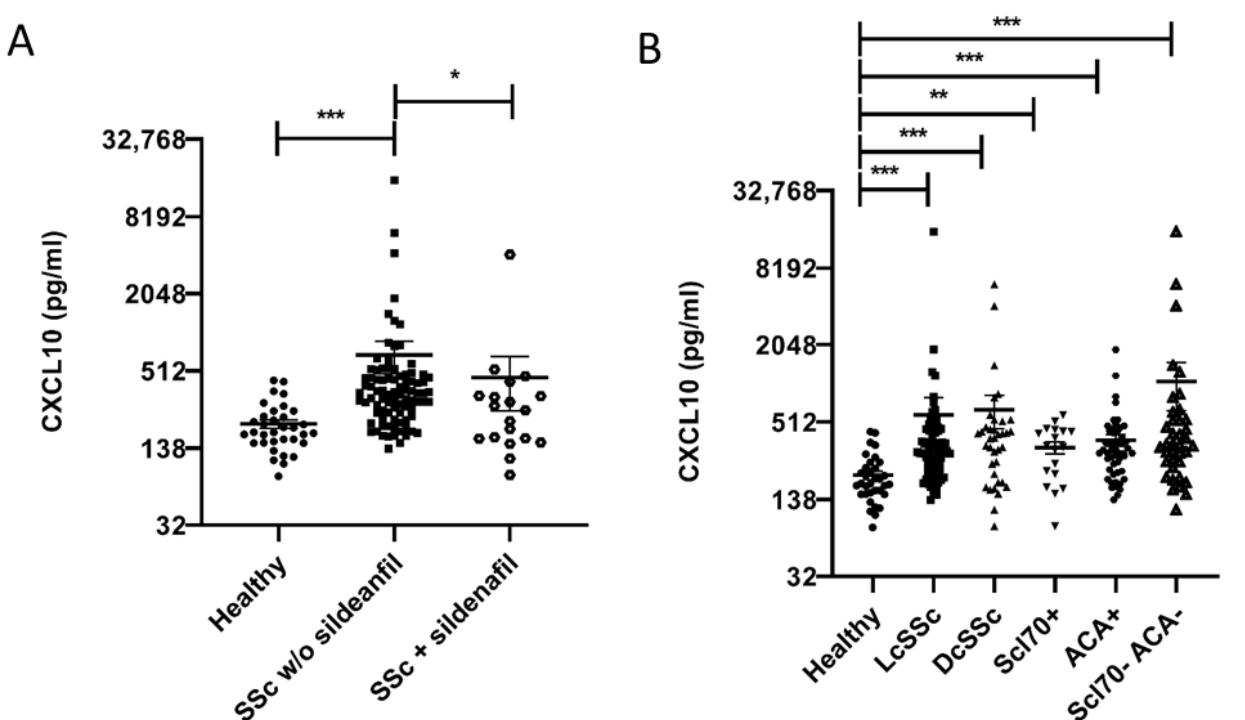
Figure 1. Circulating level of CXCL10 is higher in systemic sclerosis (SSc) patients than healthy subjects. Treatment with sildenafil significantly reduced CXCL10 serum level in SSc subjects. ( A ) CXCL10 serum level was significantly elevated in SSc patients without sildenafil ( n = 99) in their therapeutic regimen vs. sildenafil treated-SSc patients ( n = 17) and healthy subjects ( n = 35) (633.07 ± 183.02 pg/mL vs. 455.21 ± 211.8 pg/mL and 197.5 ± 14.89 pg/mL, respectively, * p < 0.05 and *** p < 0.001). ( B ) CXCL10 was analyzed in the sera of SSc patients divided in different subgroups: Limited (LcSSc) ( n = 72) (575.21 ± 8.49 pg/mL), diffuse (DcSSc) ( n = 37) (640.73 ± 186.33 pg/mL), anti-topoisomerase I (ScL70) positive ( n = 18) (324.22 ± 34.10 pg/mL), anti-centromere (ACA) positive ( n = 51) (370.24 ± 39.81 pg/mL) and ScL70-ACA double negative ( n = 38) (1062.74 ± 435.36 pg/mL). All the subgroups analyzed showed CXCL10 serum levels significantly higher than healthy subjects (** p < 0.01 and *** p < 0.001, respectively). No significant differences within SSc subgroups were noted. Data are expressed as CXCL10 serum level, in pg/mL (mean ± standard error of the mean (SE)). Table 1. Clinical features of the 116 SSc patients. Data are shown as mean ± standard deviation (SD), as median (range) or as number (percentage). The number in parentheses refers to the percentage of patients with the specific feature among the total patients with the available test results. Difference between groups were analyzed by Fisher’s exact test and unpaired t -test or Mann–Whitney test as appropriate. Clinically relevant criteria highlighted in bold.